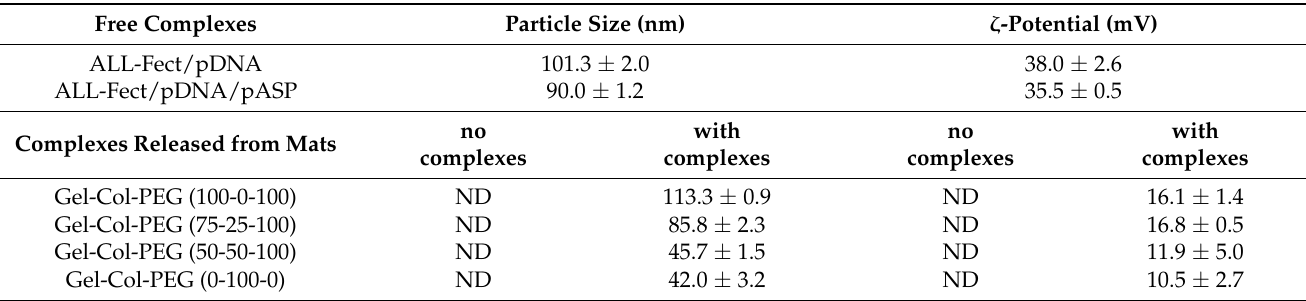
Table 2. Size and ζ -potential of original free particles and particles released from different Gelatin-Collagen-PEG mats. Only All-Fect/pDNA/pASP complexes were entrapped in mats. ND: Not detected. Free Complexes